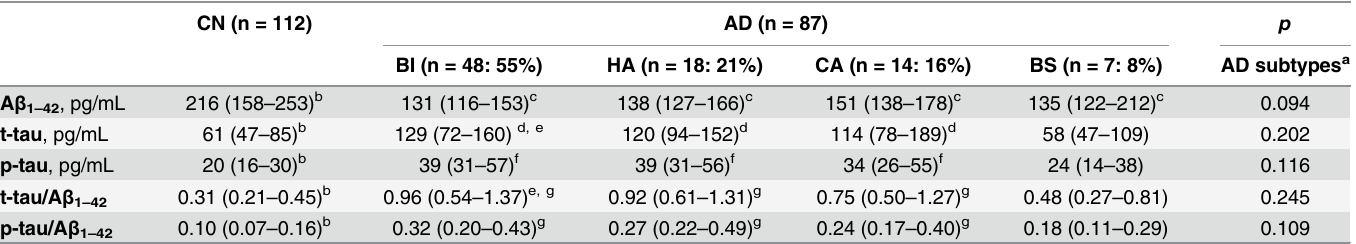
Table 4. CSF biomarkers of subjects in CN and AD